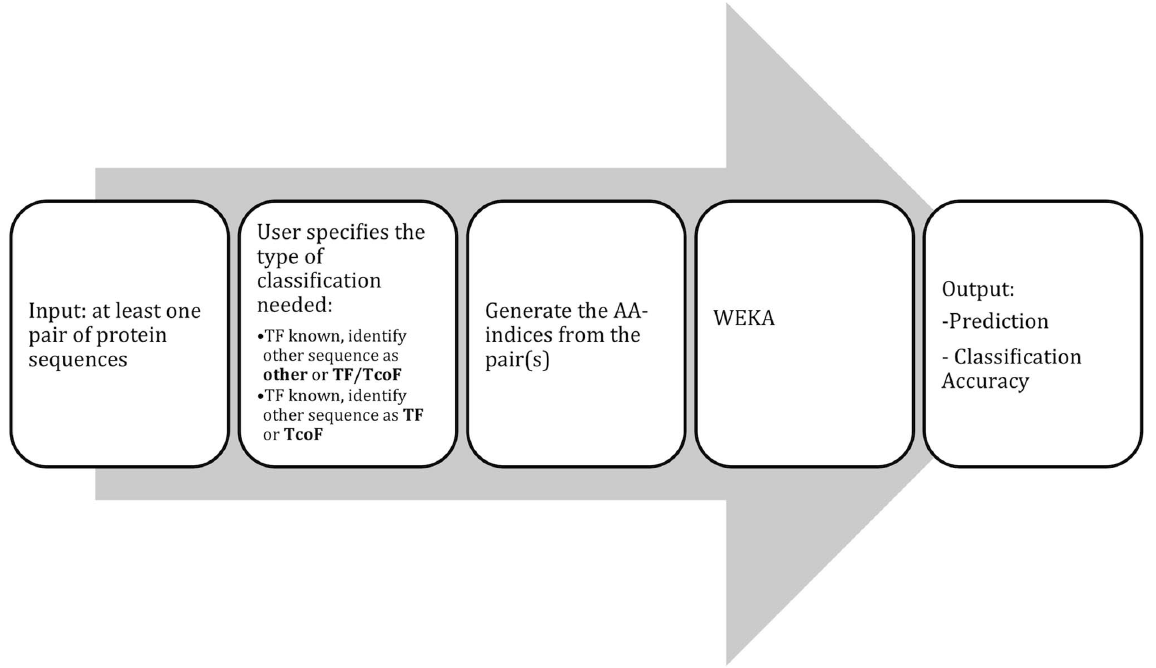
Figure 1. Workflow of Analysis Pipeline. Given a set of binding proteins and depending on the model type, the analysis pipeline predicts the functional identity of one of a TF binding partner. After a pair of binding proteins is given as the input, the pipeline calculates numerous amino acid physico-chemical properties for the pair and generates a matrix of feature vectors. This matrix of feature vectors is submitted to the Random Forest classifier that returns the predicted functional class assignment and the associated confidence score. The latter is a measure of how strongly the average feature-class probabilities of all decision trees pointed to each class based on the information gain of those decision trees.